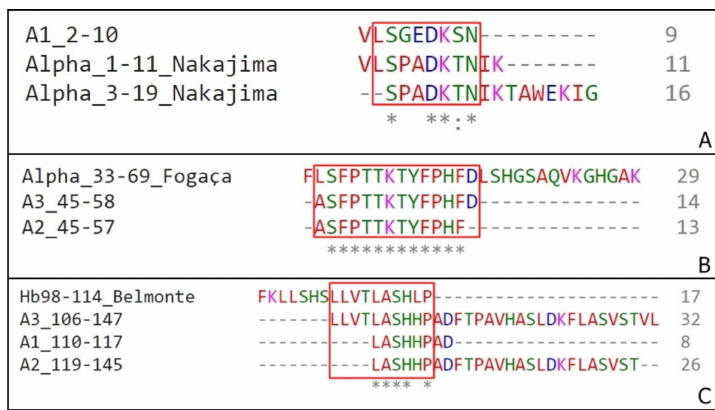
Figure 6. Sequences homology between α chain fragments. ( A ) Alignment of Nakajima’s